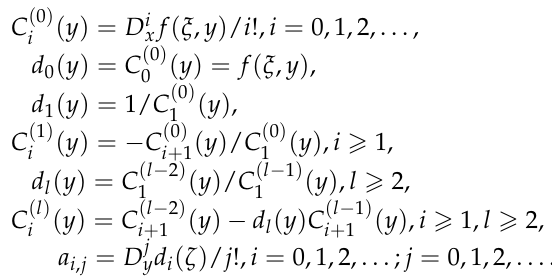
Algorithm 3. Viscovatov-like algorithm to calculate the coefficients d i ( y ) , i = 0, 1, 2, . . . , and a i , j , i